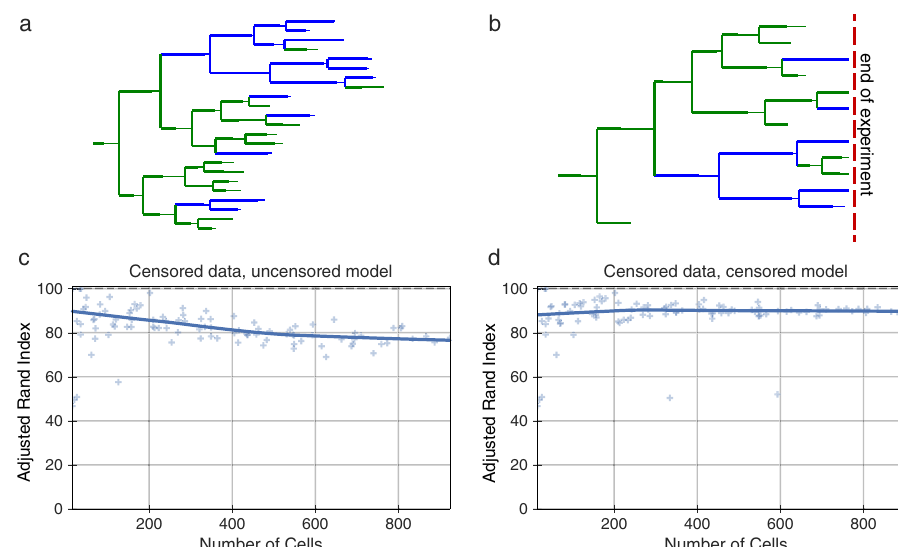
Fig. 3 Experiments of fi nite time necessitate data censorship corrections. a An example synthetic, uncensored two-state lineage. b An example synthetic, censored two-state lineage. Cells in state 0 and 1 are shown in green and blue, respectively. c State assignment accuracy with censored lineages using an uncorrected model. d State assignment accuracy with censored lineages using the corrected model. Each scatter point represents the state assignment accuracy of the model when fi t to a lineage with the indicated number of cells. The solid lines show the Lowess trendline of the individual run accuracies. 100 trials are plotted. The accuracy of state assignment is measured by the adjusted rand index, a similarity measure that can serve as an accuracy for unlabeled clustering